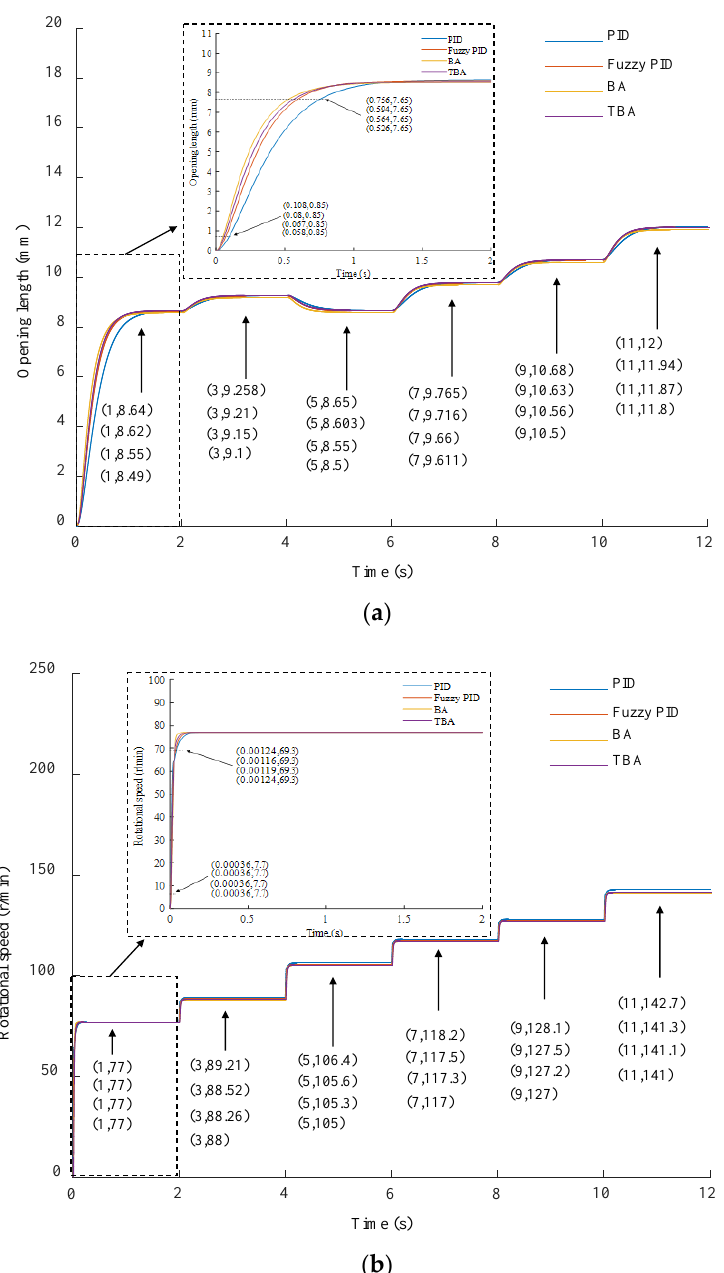
Figure 7. Comparison of four different PID controllers for fertilization rate varying from 350 kg ha − 1 to 600 kg ha − 1 : ( a ) Comparison of continuous opening-length control of PID, fuzzy PID, PID improved by BA, and PID optimized by TBA; ( b ) comparison of continuous rotational-speed control of PID, fuzzy PID, PID improved by BA, and PID optimized by TBA.